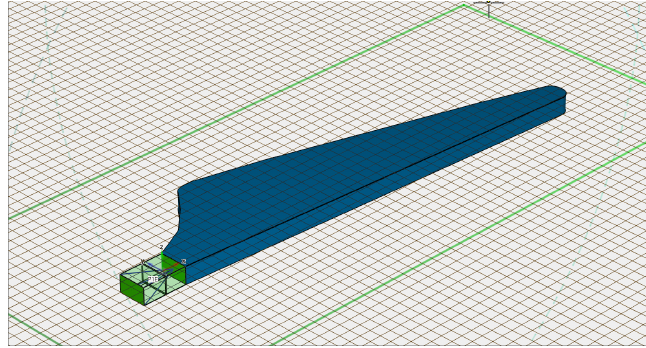
Figure 6. The simple blade design with a source.